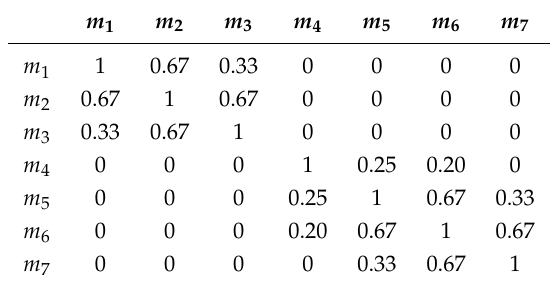
Table 1. The client-based similarity between each pair of methods in the class X . m